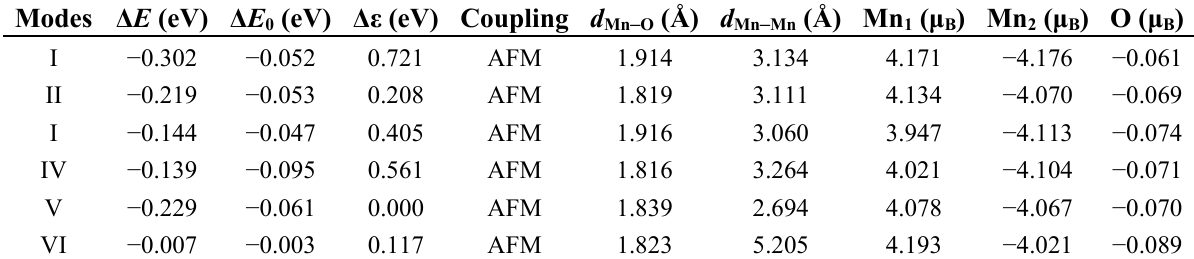
Table 1. Magnetic coupling modes, energy, bond lengths, and magnetic